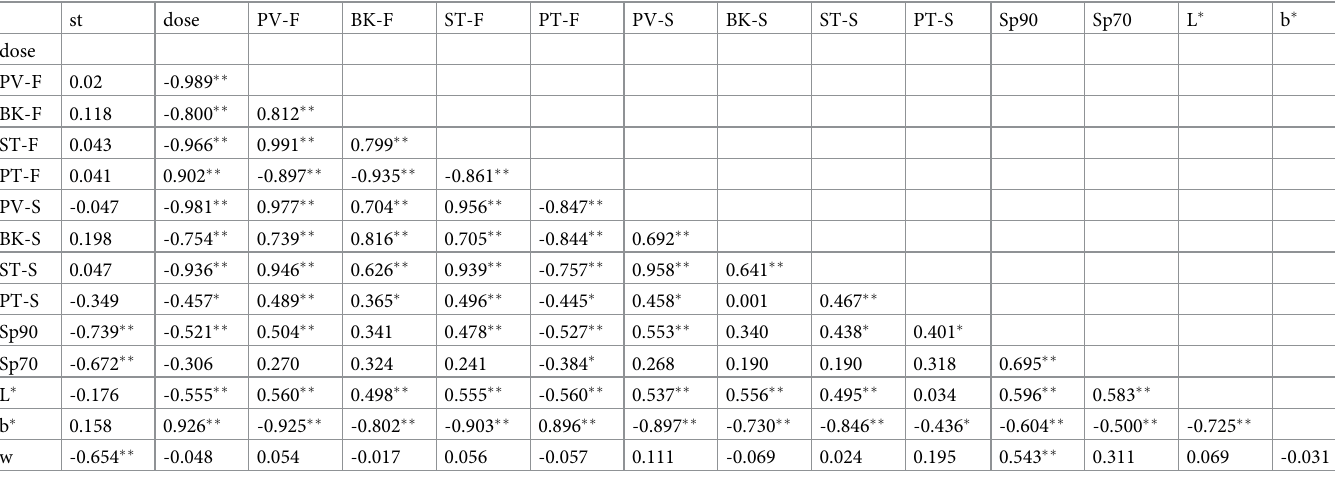
Table 5. Correlation coefficients among various functional properties of the irradiated rice sample at 25 ˚C a .